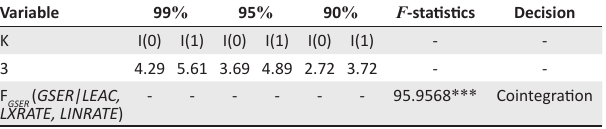
TABLE 3: Critical value bound for F -statistics with trend and